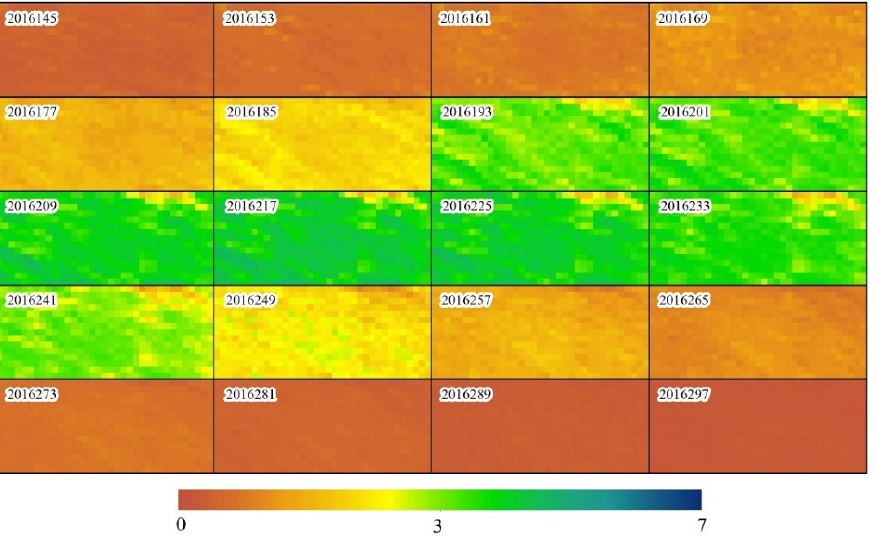
Figure 9. Spatial distributions of LSTM fusion LAI during crop growing season in 2016. The region is the same as the 500 m-resolution grids in Figure 2d. The text on the top of every image (DOY) corresponds to the 8-day composite dates in the MOD09A1 reflectance product.